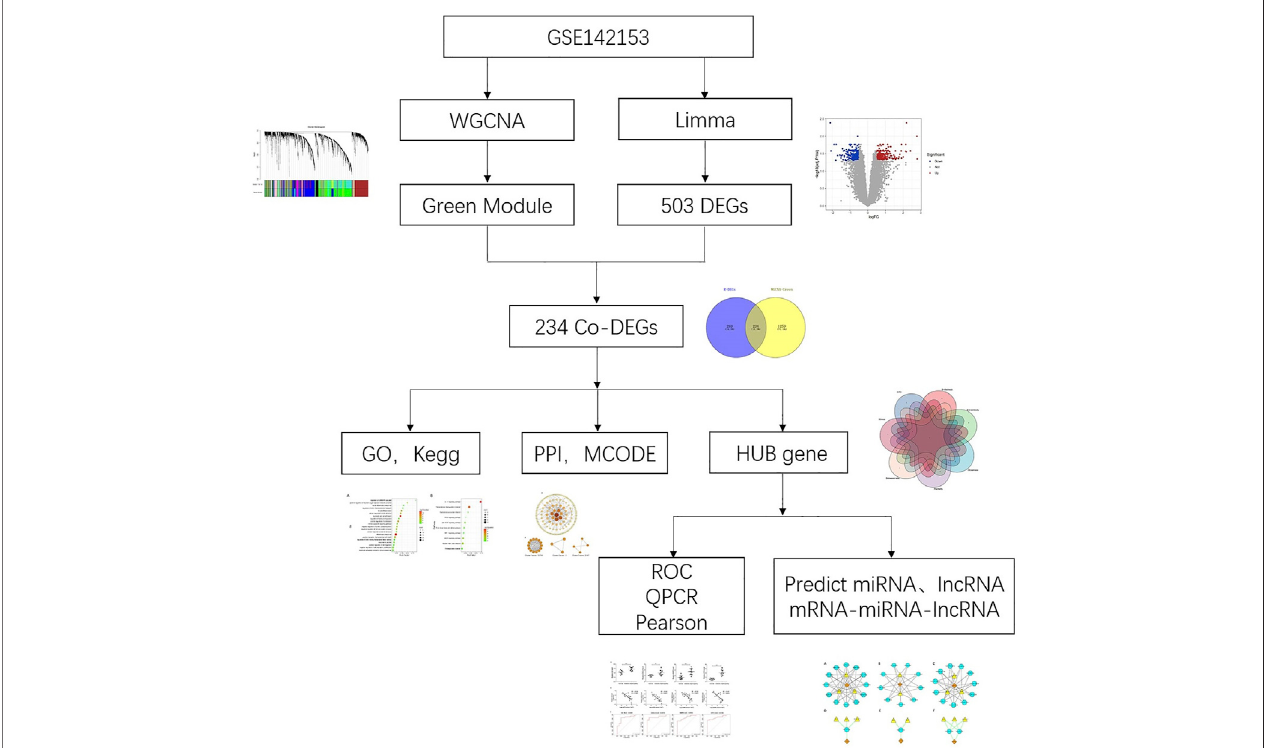
FIGURE 1 | Research fl ow